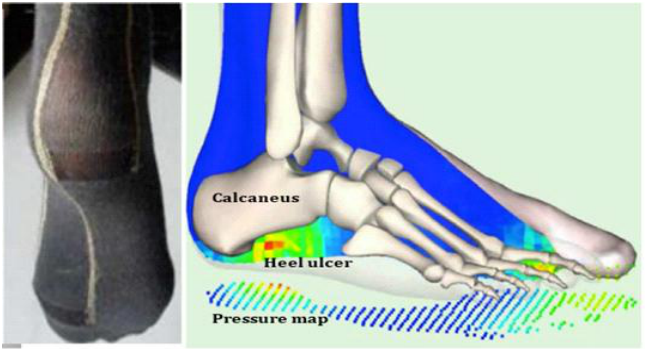
Figure 11. Left: smart sock by Texisense made of a sensitive textile giving pressure information during a real walk, following progress during the reeducation process. Right: combination of pressure information with an osteo-densitometry study showing the consequences of pathologic running on bone reconstruction.